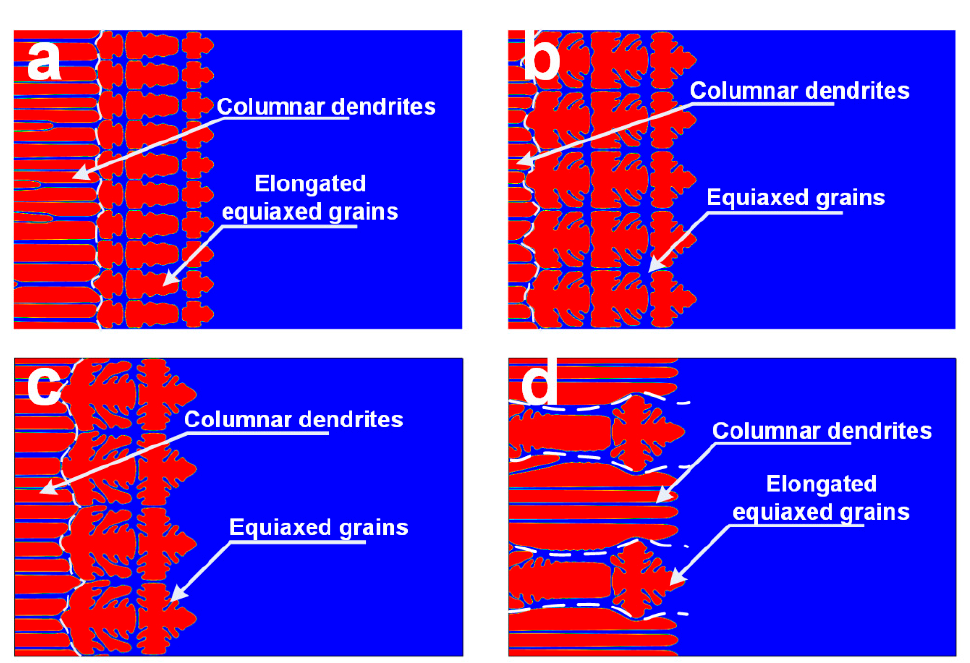
Figure 9. Effects of the nucleation density on the CET for U n = 11 K and X f = 200 ∆ x : ( a ) D n = 200 ∆ x ; ( b ) D n = 400 ∆ x ; ( c ) D n = 500 ∆ x ; ( d ) D n = 1000 ∆ x .